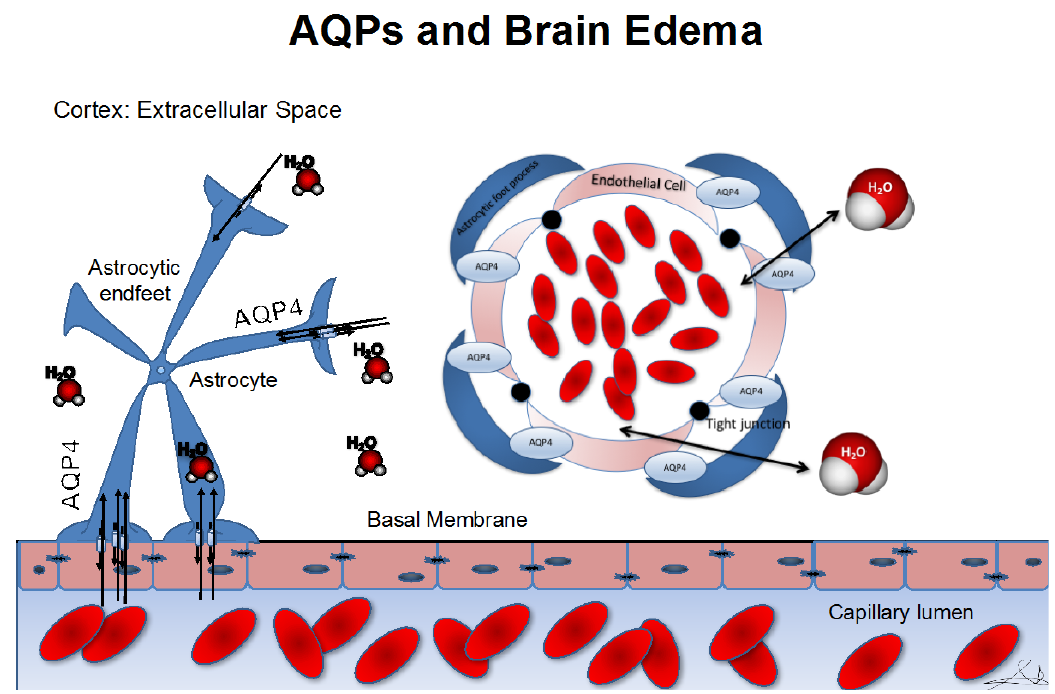
Figure 1. AQP4 distribution in relation to astrocytic feet processes. On the left hand side of the picture, a sagittal slice of brain extracellular space is depicted together with wrapping of the astrocytic endfeet around the endothelium; On the right hand side, the same principle is demonstrated with a coronal dissection of the vessel. Swelling of the astrocytic endfeet after influx of water through AQP4 water channels is characteristic in cytotoxic edema.